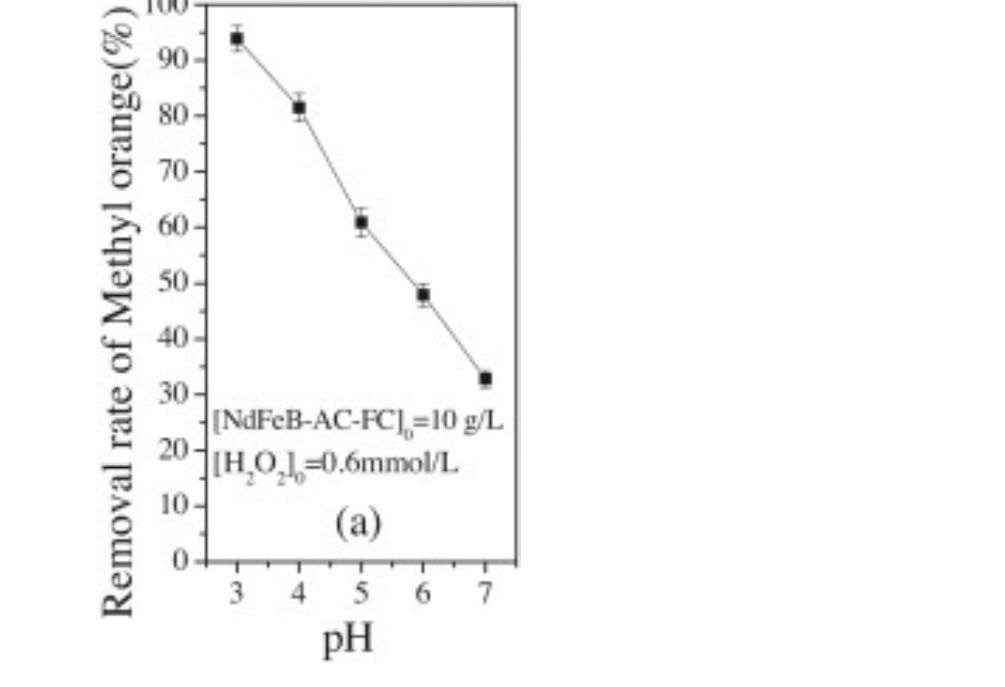
Figure 2. pH effect on methyl orange degradation in the Fenton process (adapted and edited from [57,58]).